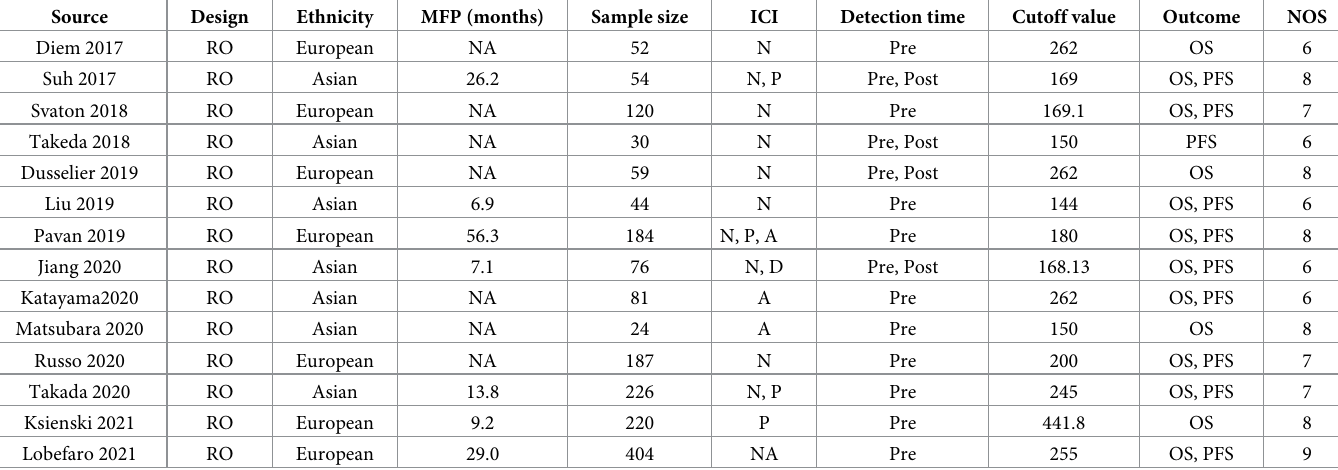
Table 1. Main characteristics of the studies included.